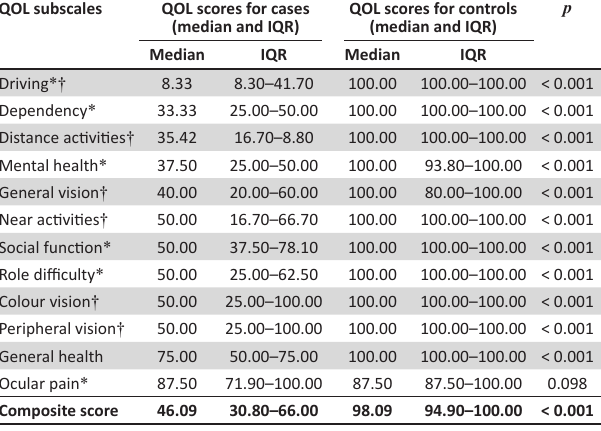
TABLE 3: Comparison of National Eye Institute Visual Function Questionnaire 25 scores of cases ( n = 41) with controls ( n = 41), with significance set at p <